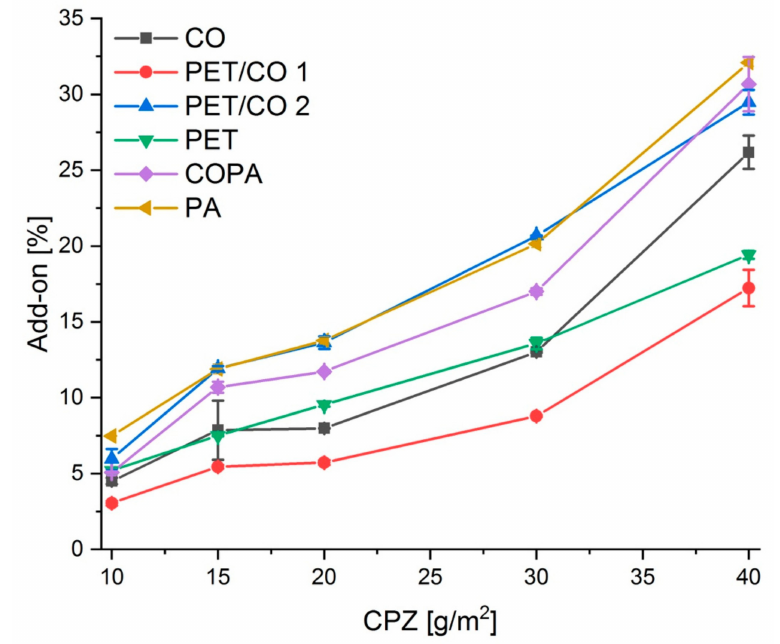
Figure A1. Add-on of the unwashed